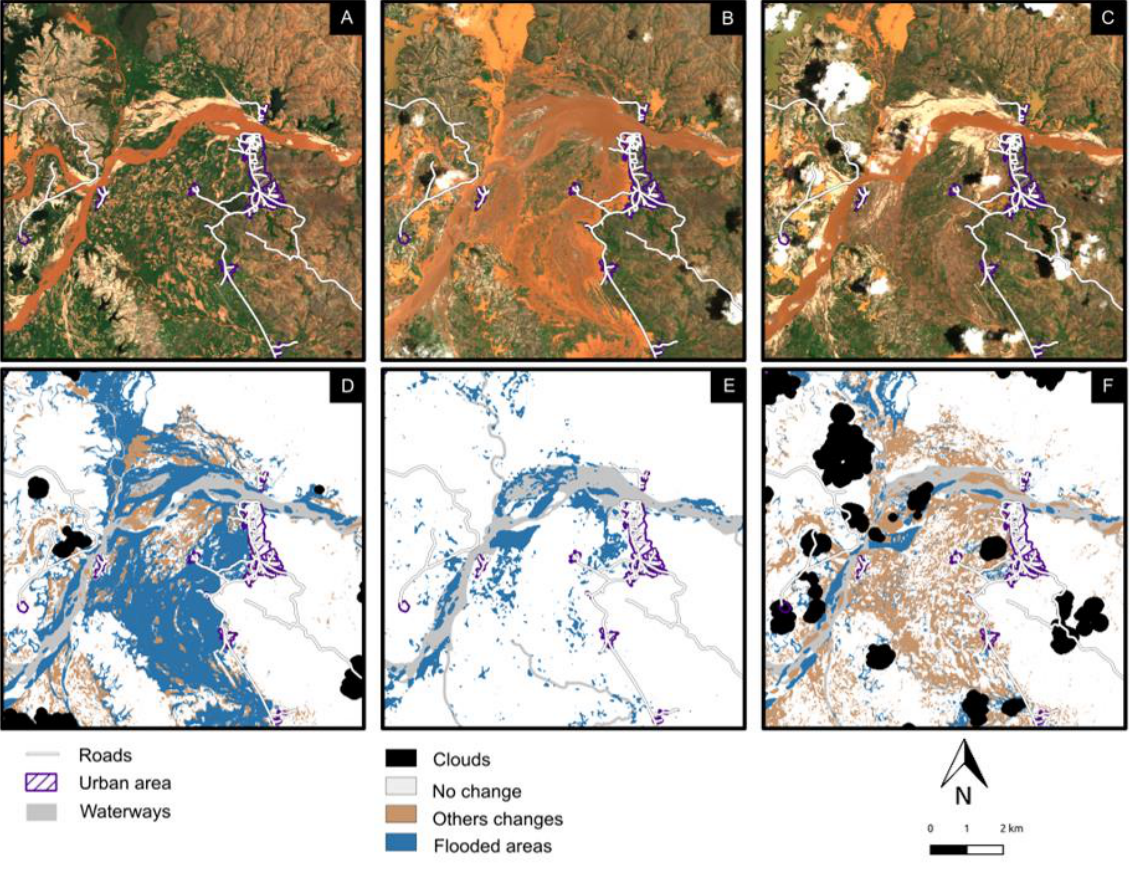
Figure 4. AVA cyclone impacts in Miandrivazo region in January 2018. Sentinel-2 imagery from (A) 2017/12/25, (B) 2018/01/09, (C) 2018/01/19; (D) CVA results from 2018/01/09; (E) NDR result from 2018/01/17; (F) CVA result from 2018/01/19 ( © OSM contributors, © Copernicus data (2017-2018) ).